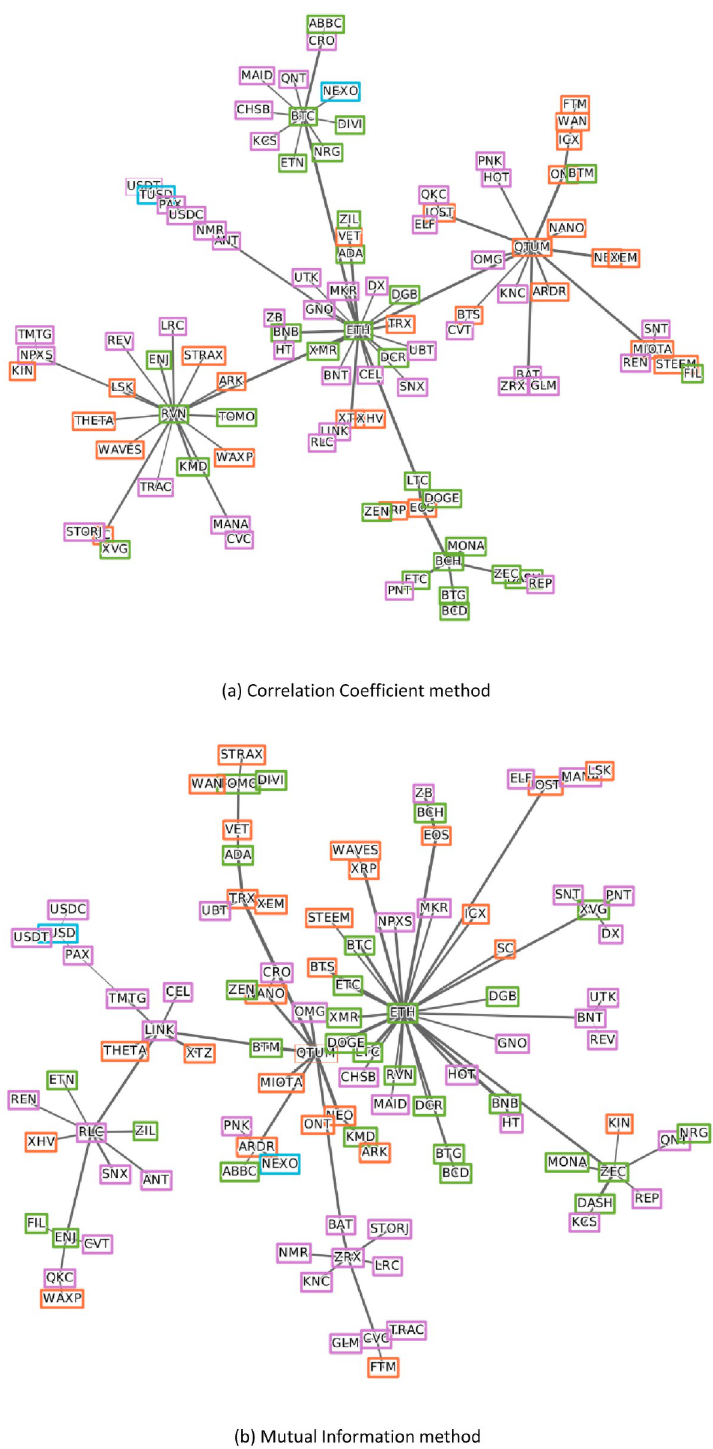
Fig 7. MST for each method in post-COVID-19 period. Colors represent types (see Table 1) and the edge’s thickness shows inversely proportional to the distance between two nodes.